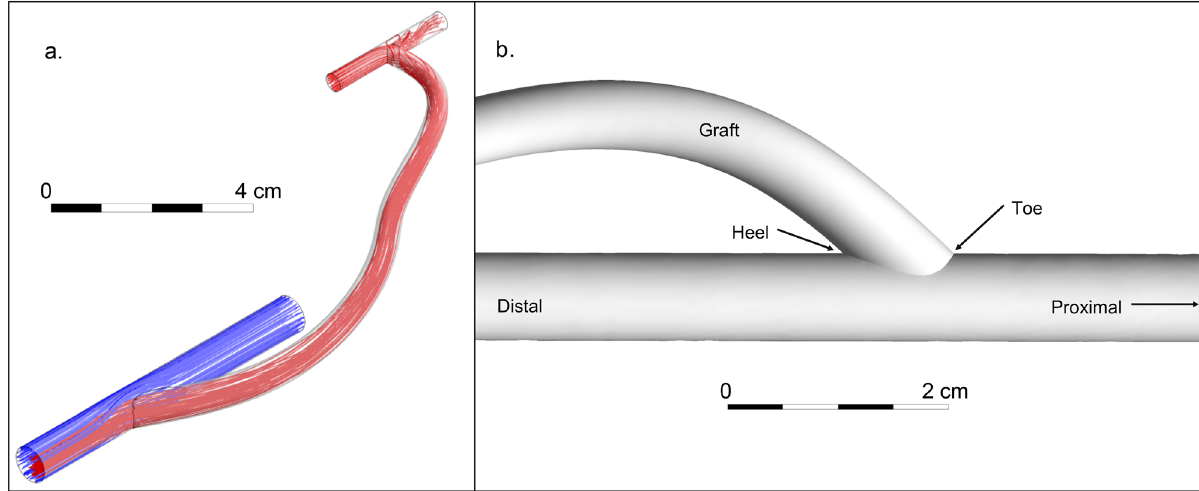
Figure 1. ( a ) Idealized model of a brachio-axillary arteriovenous graft in an adult human. For illustration, streamlines estimated by computational fluid dynamics analysis are shown: red streamlines represent arterial blood flow, and blue streamlines represent venous blood flow. ( b ) Venous end of the graft demonstrating the beveled hood of the arteriovenous graft-to-vein